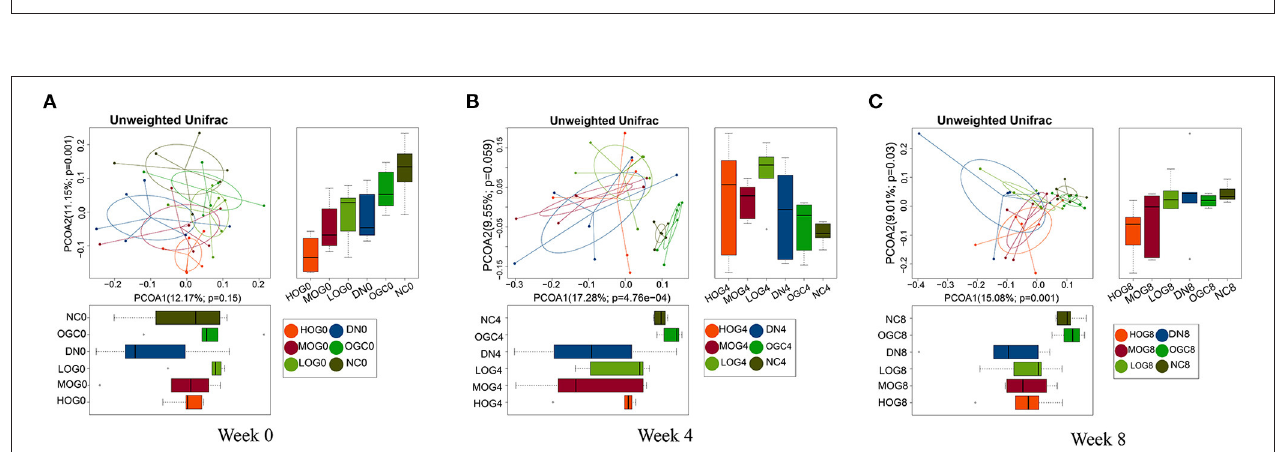
FIGURE 4 | Shannon index of gut microbiota at 0 (A) , 4 (B) , and 8 (C) weeks. Shannon index (B) was used to reflect the diversity of the sample population: the larger the Shannon, the higher the diversity of the flora.